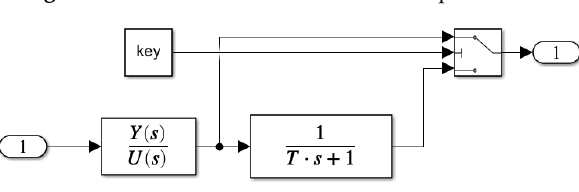
Figure A1. Part of the simulation of Example 2.